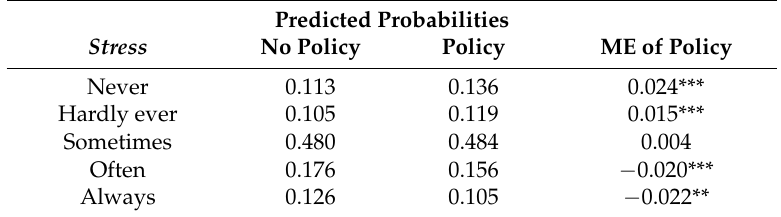
Table 7. Estimated marginal effect of formal policy on respect and dignity at work on work- related